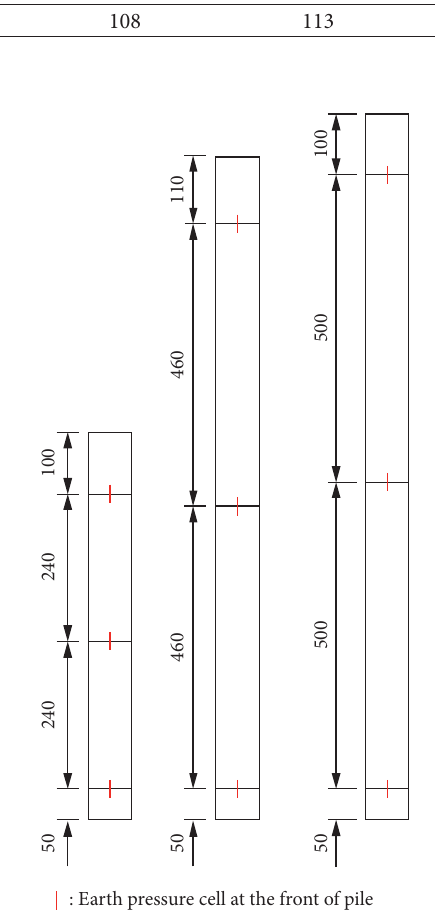
Figure 19: Layout of earth pressure cell